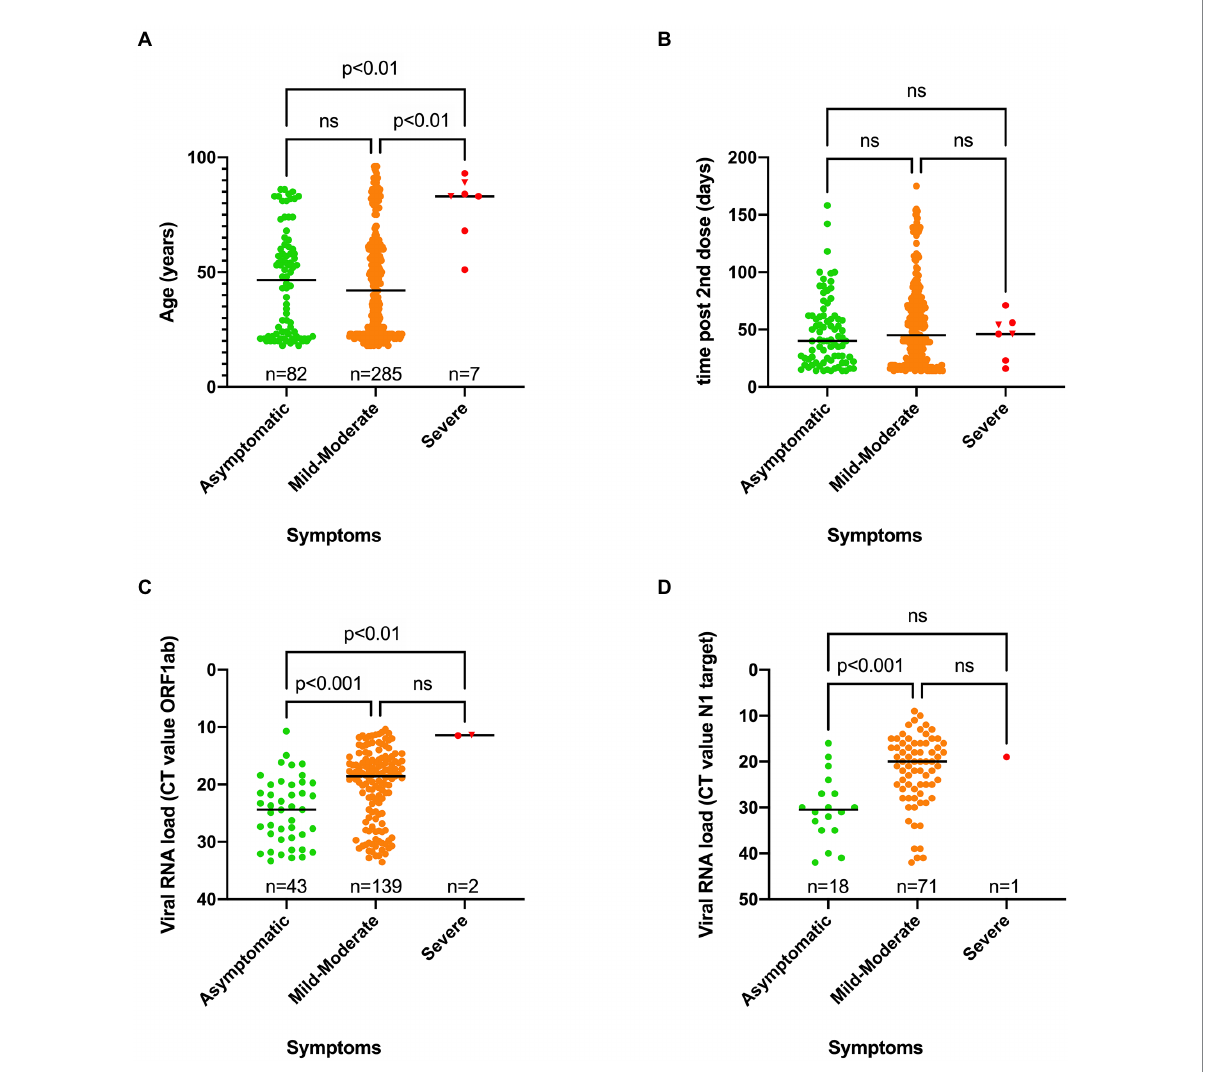
FIGURE 4 Scatter plots showing the distribution of age vs. symptoms (A) , time of positive RT-PCR test after receiving the second dose vs. symptoms (B) , Viral RNA load vs. symptoms for the ORF1ab target (C) or N1 target (D) as determined using two independent workflows. A Kruskal-Wallis test was performed to compare the median age (A) , median time of positive RT-PCR test after receiving the second dose (B) and the viral RNA load (C,D) between the three categories of symptoms. When a statistically significant result was obtained, Dunn’s multiple comparison test was performed post hoc to identify which groups significantly differed. ns, not significant. A fatal outcome was indicated by a reverse triangle symbol. The low number of severe cases might not provide enough statistical power to reveal statistically significant differences between this category and